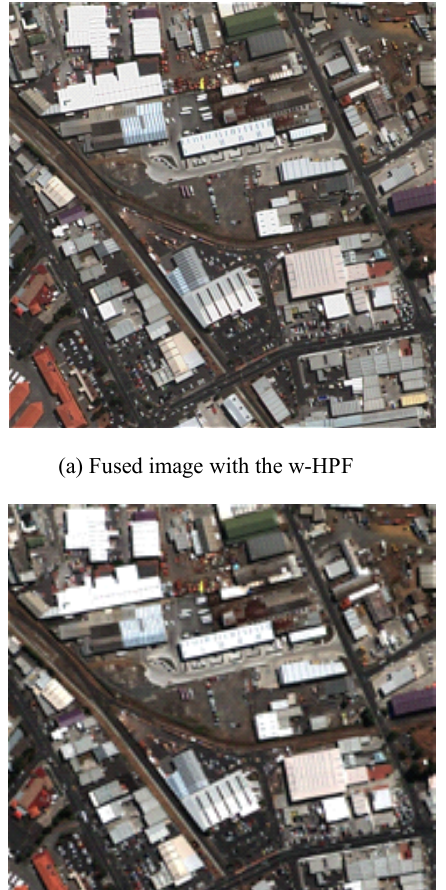
Figure 5. MS image and Fused image in degrade scale